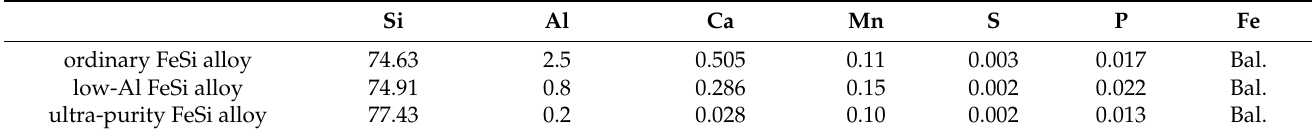
Table 1. Chemical compositions of ferrosilicon alloys (mass%).